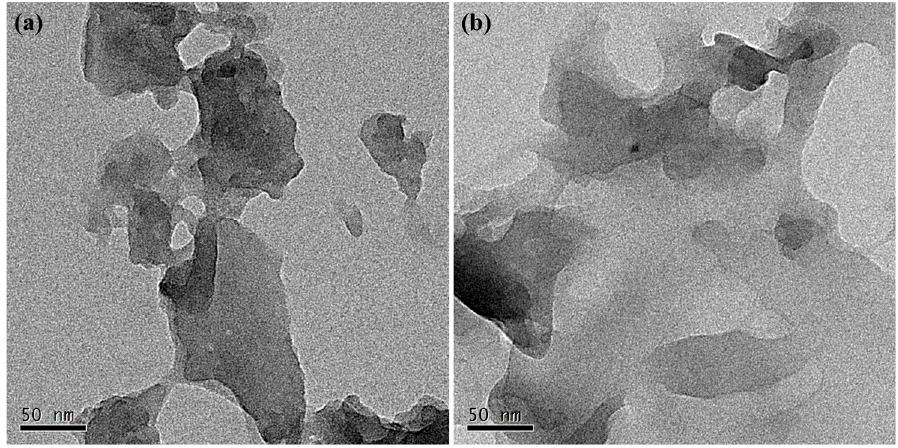
Figure 1. TEM images of ( a ) OCN and ( b )